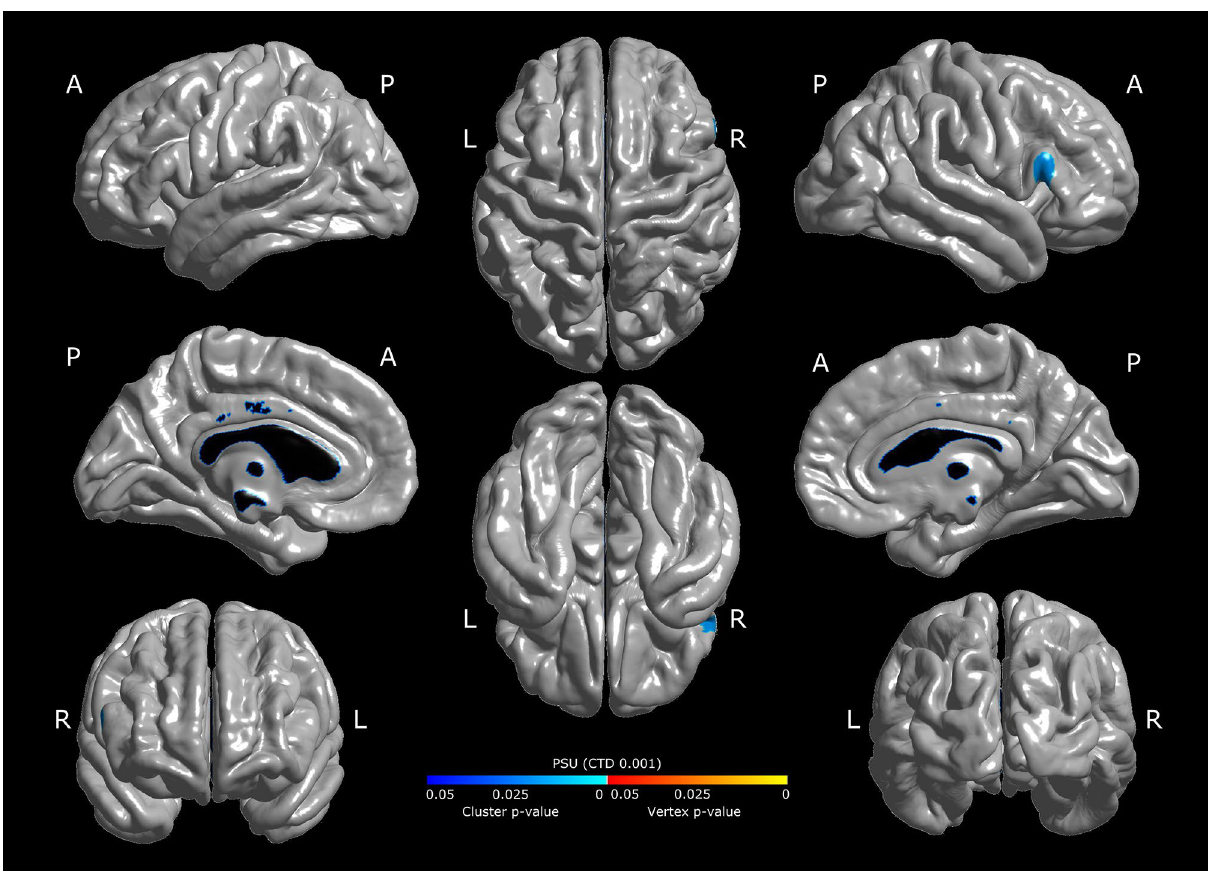
Figure 3. Significant clusters of the correlation between cortical thickness and the University Selection Test outcomes (PSU) (language + mathematics), corrected by sex and socioeconomic status. Color represents the p -value for a cluster in the right frontal gyrus that survives the multiple comparison correction (with the most demanding correction, CTD p < 0.001, cluster corrected p < 0.05). A: anterior; P: posterior, R: right, L: